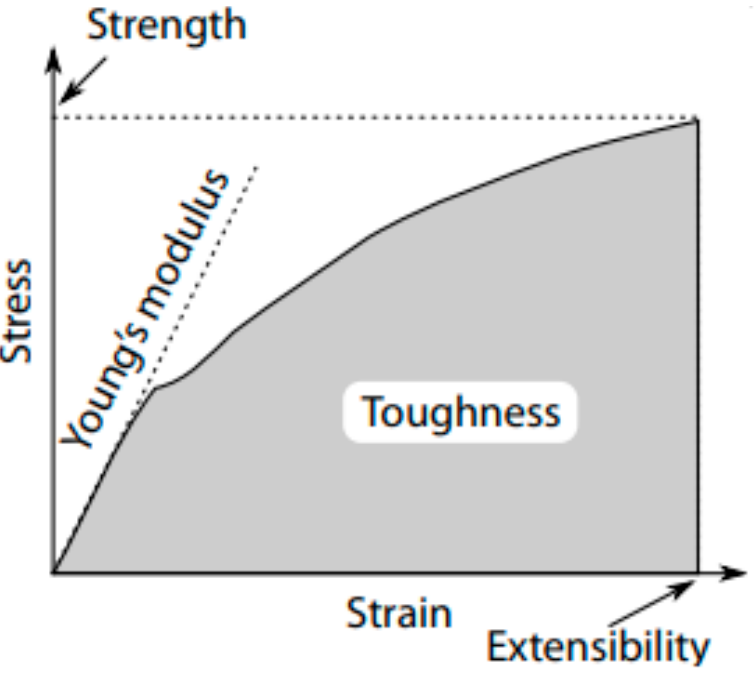
Figure 5. A typical stress–strain curve as derived from tensile testing of silk fibres. The curve is used to determine the ultimate strength (the stress at rupture), extensibility (strain at rupture), toughness (the total work of extension, calculated as the area under the stress strain curve), and Young’s modulus, or stiffness (the slope of the curve during the initial elastic phase for each specimen) of the fibres as